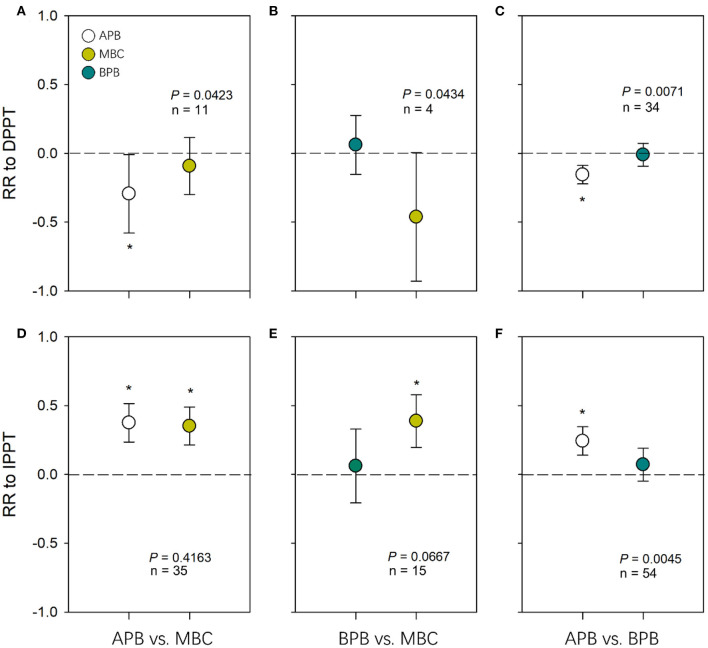
Pairwise comparisons of response ratio between APB, BPB, and MBC in response to DPPT (A, B, C) and IPPT (D, E, F). The error bars represent 95% confidence intervals. P values are given to show the significance of pairwise comparisons. Asterisks indicate the average effect sizes as they differ from zero (P < 0.05). The dotted lines indicate the effect size of zero. DPPT, decreased precipitation; IPPT, increased precipitation.